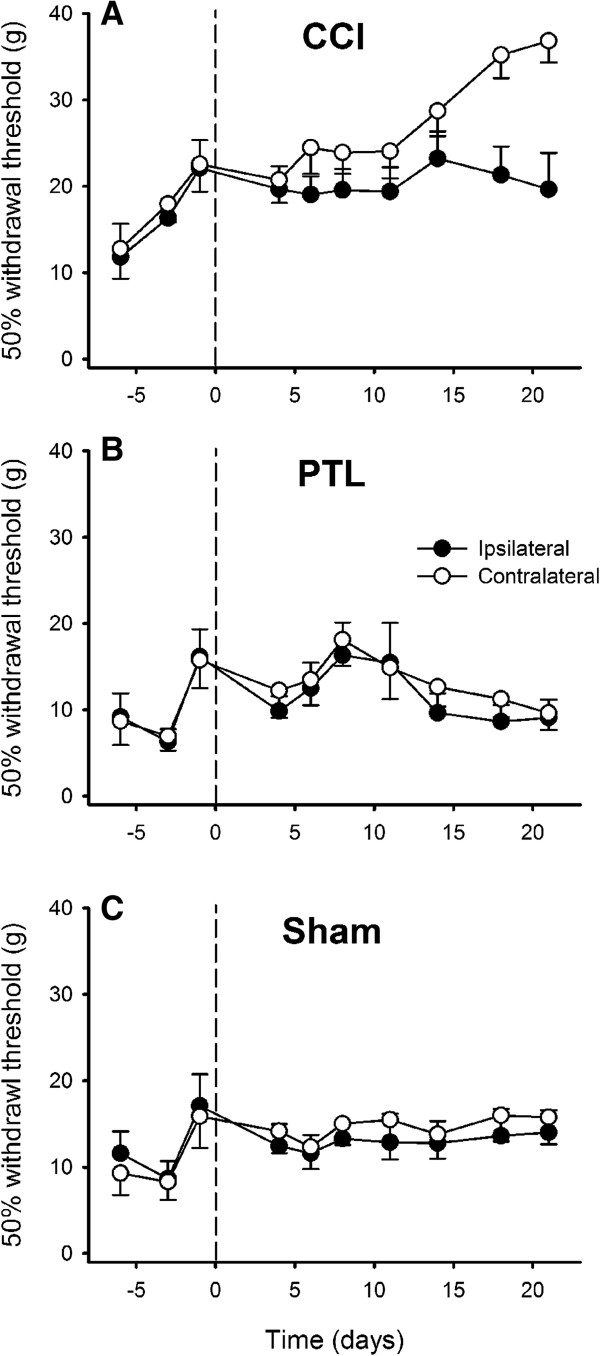
Time course of the development of mechanically-evoked behaviours after injury of the mental nerve. 50% withdrawal thresholds evoked by graded stimulation of the chin hairy skin with von Frey monofilaments after chronic constriction injury (CCI; A), partial tight ligation (PTL; B) and sham operation (C) of the mental nerve. The operation was performed on day 0 (indicated by the dashed line). Symbols are mean ± 1 S.E.M.